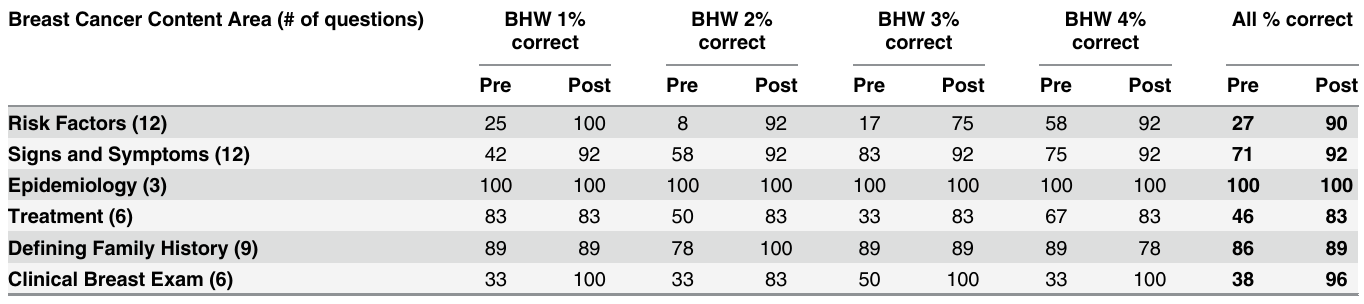
Table 2. Pre- and post-training survey results for Breast Health Workers. Breast Cancer Content Area (# of